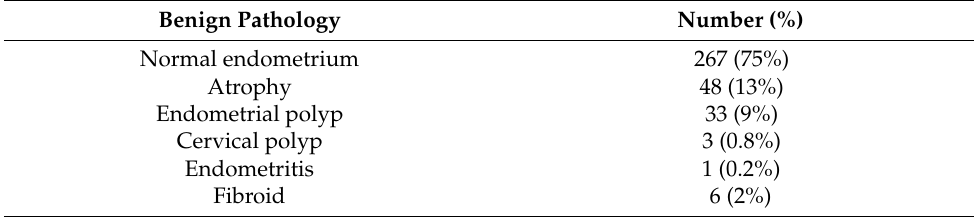
Table 3. Final diagnosis of control group.